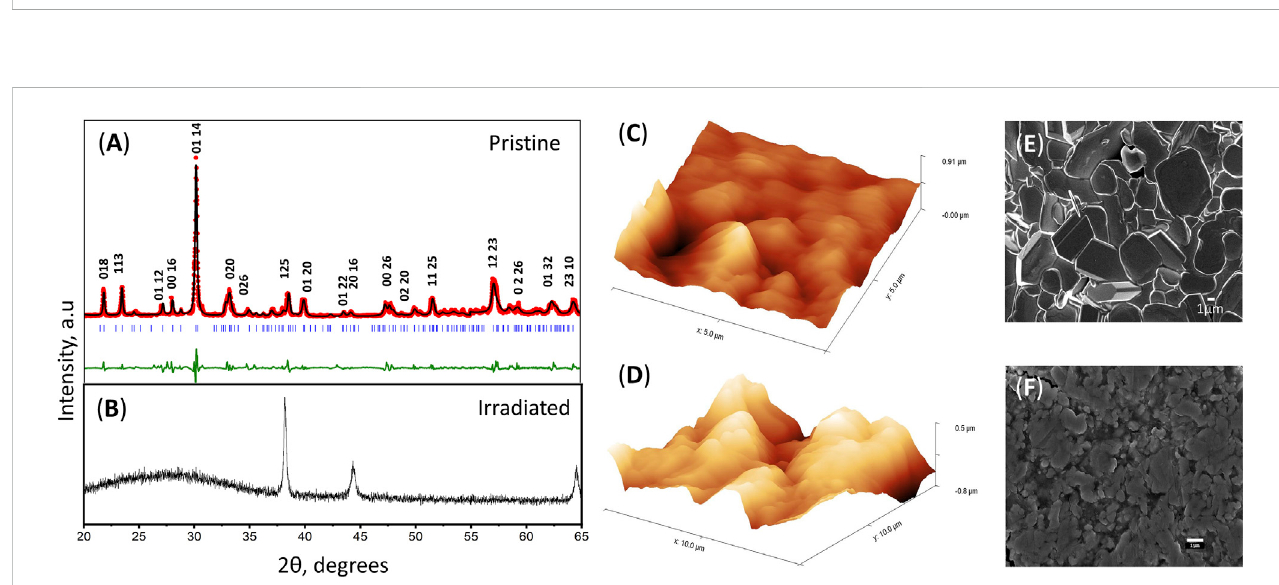
FIGURE 1 Thelongitudinal (A) andcrosssectional (B) pro fi leofKBTWceramicpelletwhenirradiatedby Ni +11 ions. (C) Thenuclearandelectronenergylosspro fi leas a function of penetration depth from sample surface.